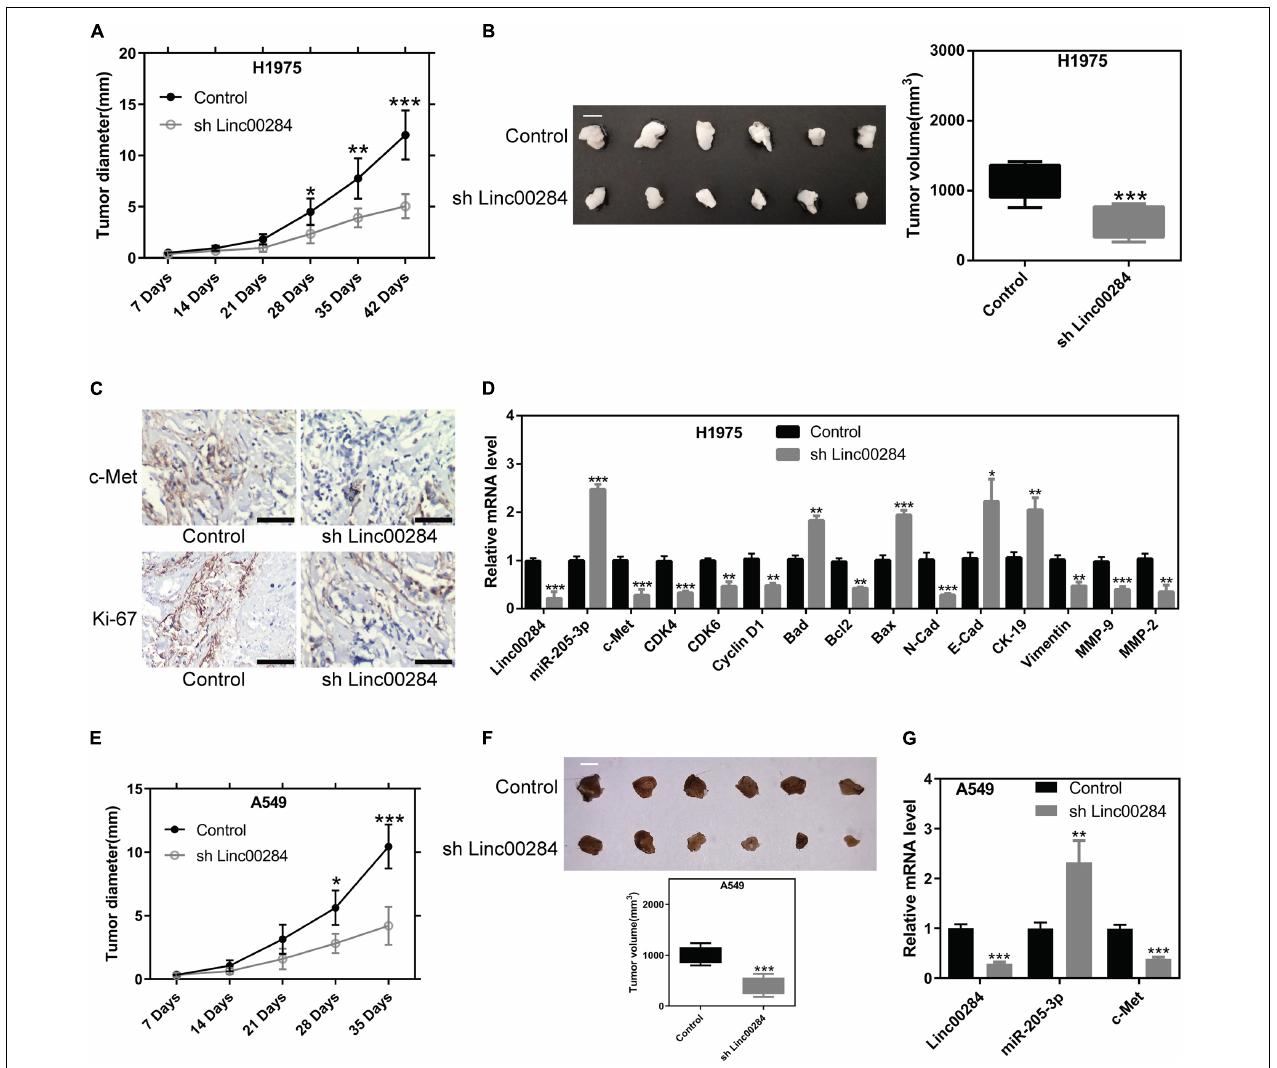
FIGURE 8 | Linc00284 silencing suppresses tumor growth in vivo . (A) Statistical analysis of the tumor diameter at different time points following implantation ( n = 6). (B) Representative images and quantification of tumor volume at 42 days following implantation. Scale bar, 1 cm. (C) Immunohistochemistry was performed to detect c-Met and Ki-67 expression levels in tumor tissues. Magnification, × 40. (D) mRNA levels of cell cycle- and EMT-related genes in tumor tissues from H1975 lung cancer cell-bearing mice. (E) Tumor diameter was monitored in H1975-bearing nude mice ( n = 6). Scale bar, 1 cm. (F) Tumor volume 35 days following implantation. (G) Linc00284, mi5R-205-3, and c-Met expression in tumor tissues. Data were analyzed using unpaired t -test and are expressed as the means ± SD. * P < 0.05, ** P < 0.01, and *** P < 0.001, compared with the control group. EMT, epithelial-mesenchymal